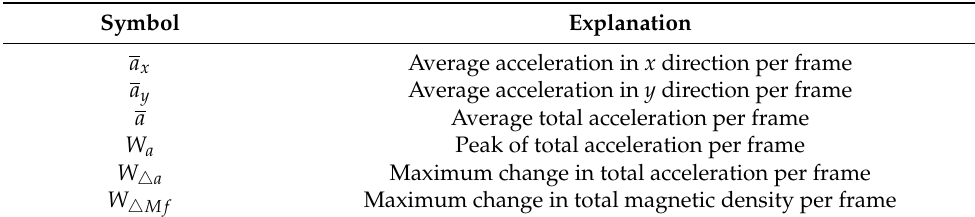
Table 1. Characteristic needed to detect for